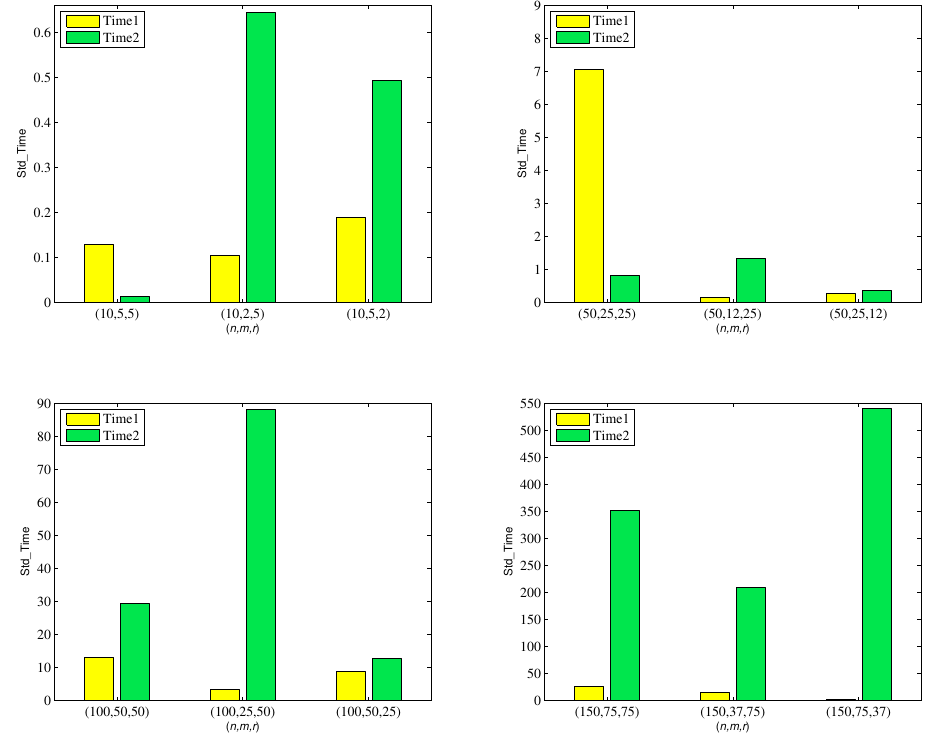
Figure 4. Standard deviation of computing times with different ( n,m,r )